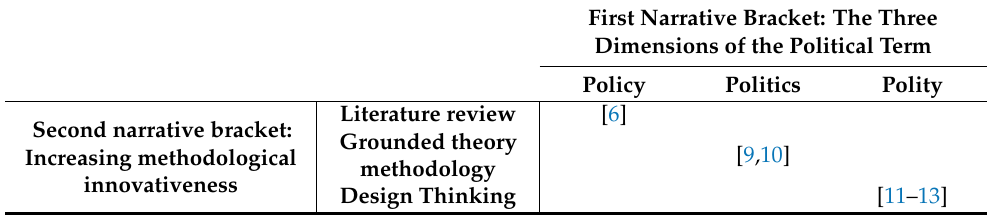
First Narrative Bracket: The Three Dimensions of the Political Term Policy Politics Polity